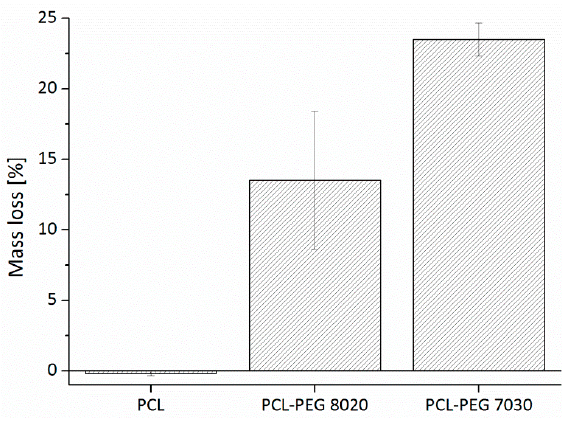
Figure 7. Mass loss of PCL and PCL-PEG blend scaffolds after three days of incubation at 37 °C.